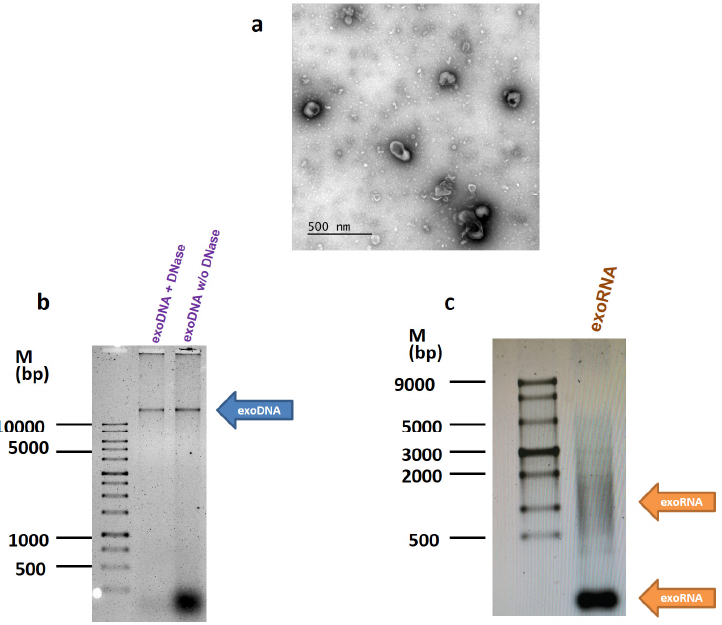
Figure 1. Detection of DNA and RNA in the exosomes. ( a ) The transmission electron microscopy of the exosomes. Exosomes were prepared from the MCF7 conditioned medium by the differential ultracentrifugation, and imaged as described in Methods. ( b , c ) DNA and RNA were isolated from the MCF7 exosomes and separated on 0.8% and 1.2% agarose gel, respectively. Sanger sequencing of exosomal DNA and RNA revealed the PIK3CA mutation E545K (c.1633G > A) in both DNA and RNA samples (Figure 2).